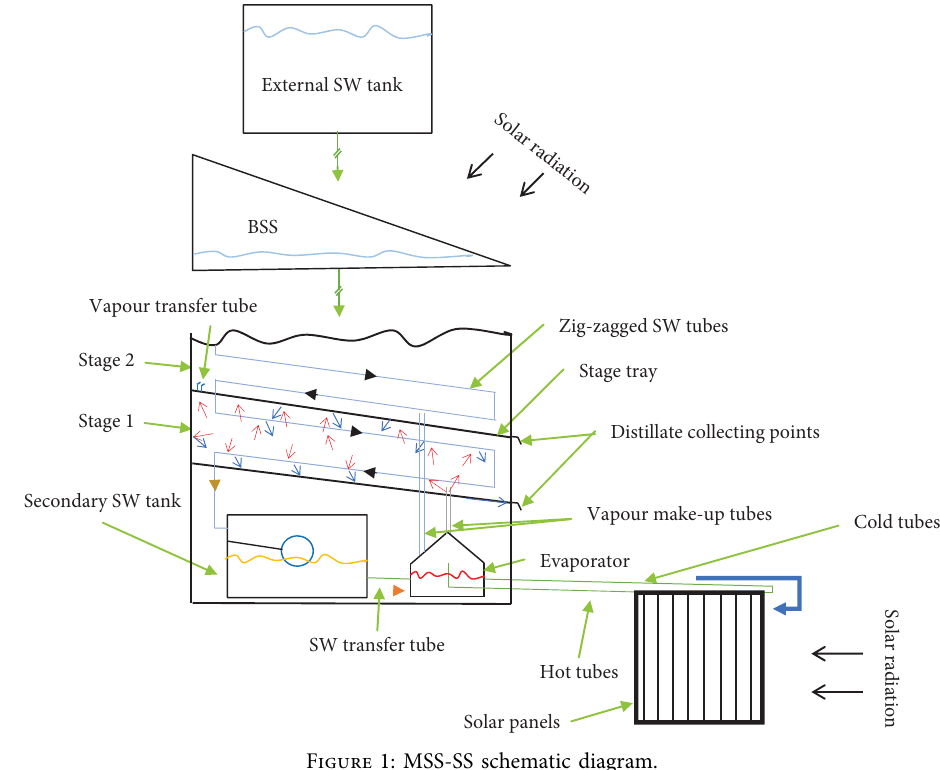
Figure 1: MSS-SS schematic diagram.